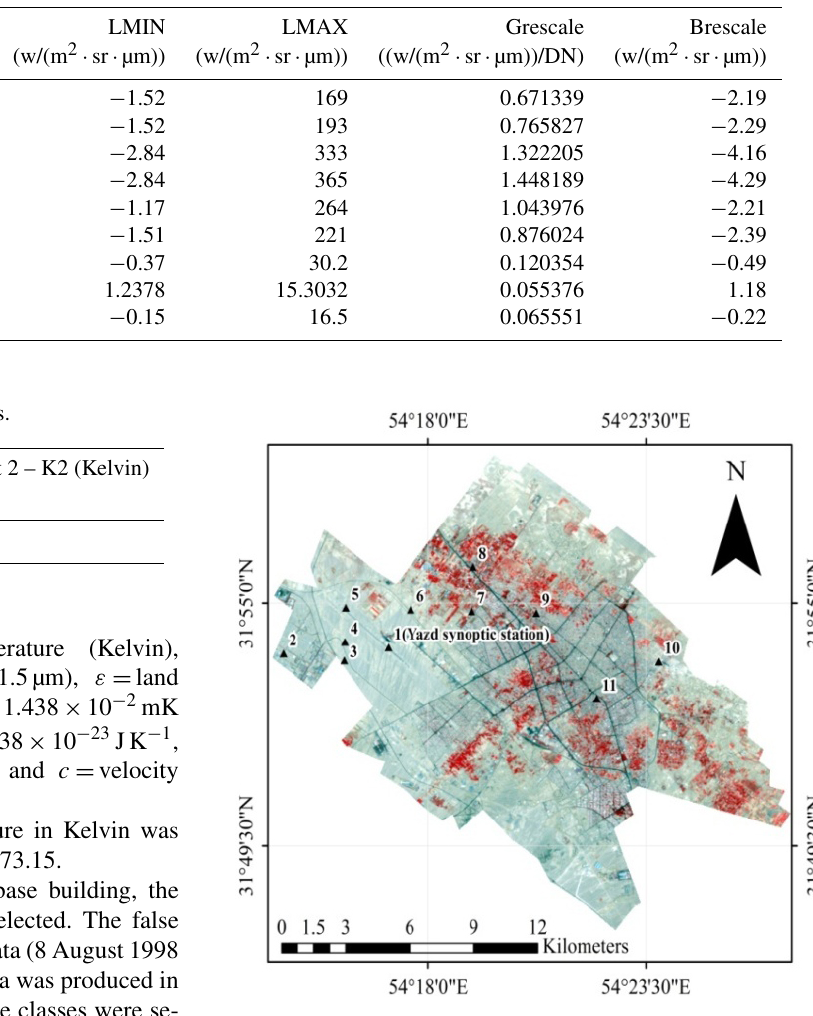
Table 1. TM spectral range and post-calibration dynamic ranges.